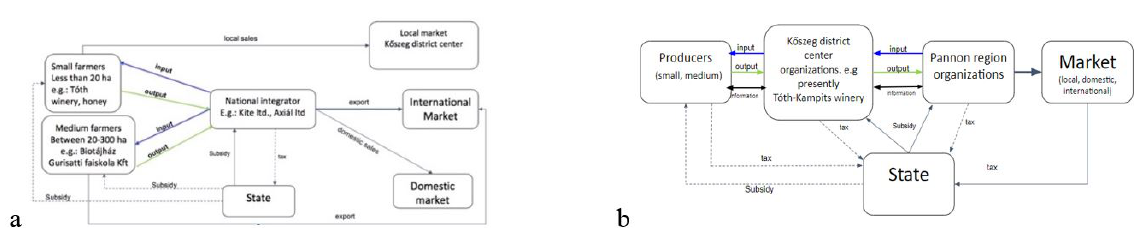
Figure 4. (a) Diagram, Current Agricultural Economy Model (b) Proposed Cooperative